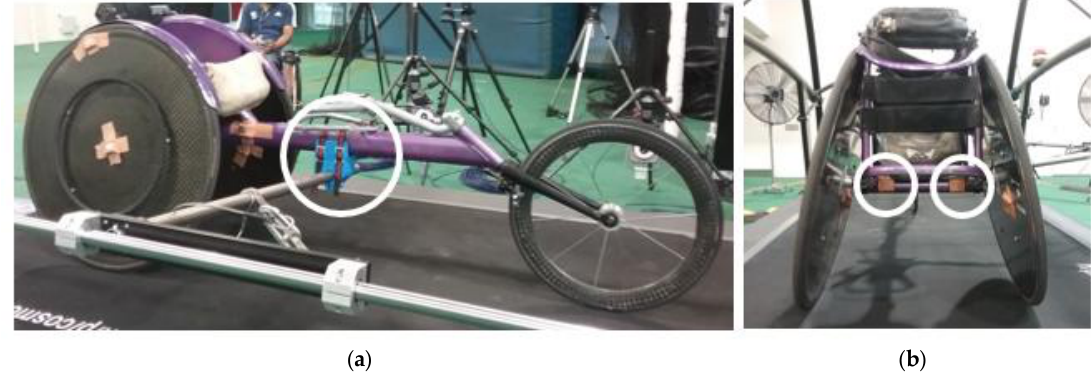
Figure 1. Testing set up. ( a ) Custom clamp (circled) keeping wheelchair on treadmill; ( b ) IMU locations